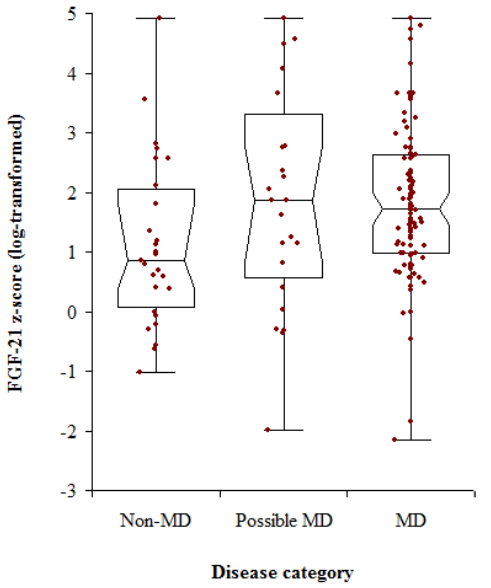
Figure 2. Distribution of FGF-21 z -scores in patients investigated for mitochondrial disease (MD). Patients were grouped according to the final diagnoses, with those who were likely to have MD but whose further investigations were still pending placed in the possible MD